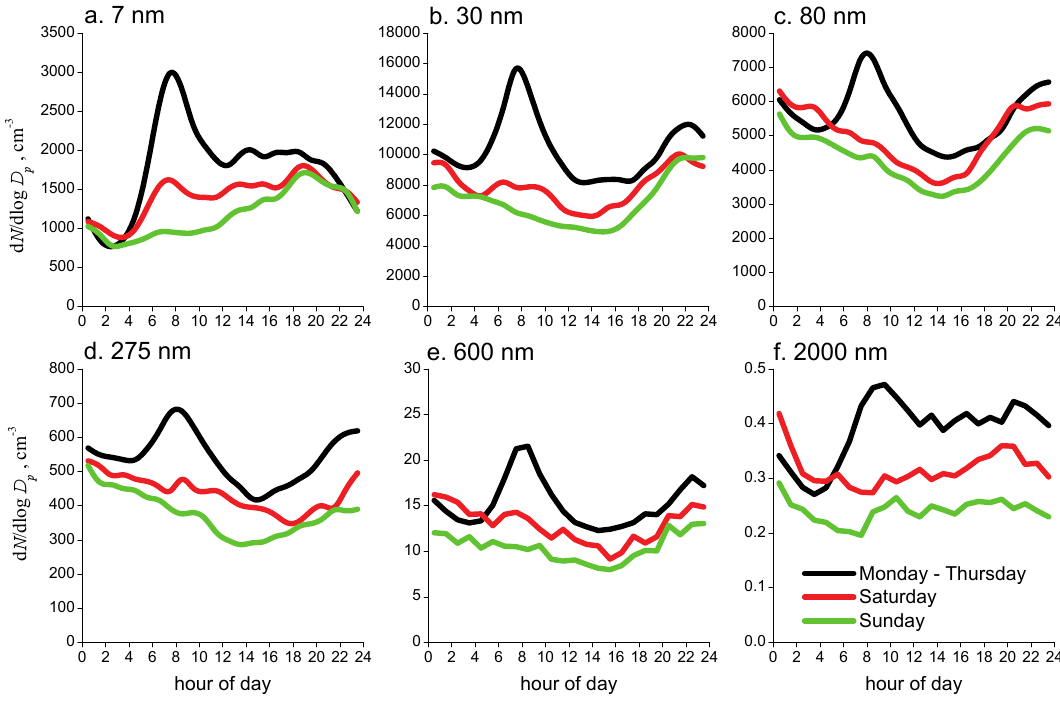
Fig. 5. Average diurnal cycle of particle number concentration at (a) 7nm, (b) 30nm, (c) 80nm, (d) 275nm, (e) 600nm and (f) 2000nm. The data cover the entire measurement campaign and are keyed after different periods of the week.